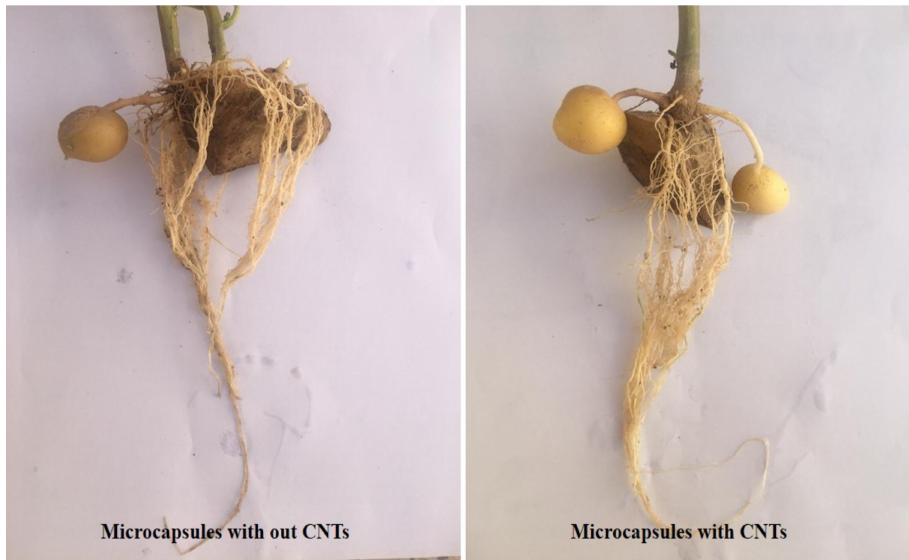
Figure 6. Effect of encapsulation of carbon nanotubes into ALG–WP microcapsules on potato plants. The extrusion method was used for preparation of microcapsules. Left panel : plant treated with ALG–WP microcapsules. Right panel : plant treated with ALG–WP–CNT